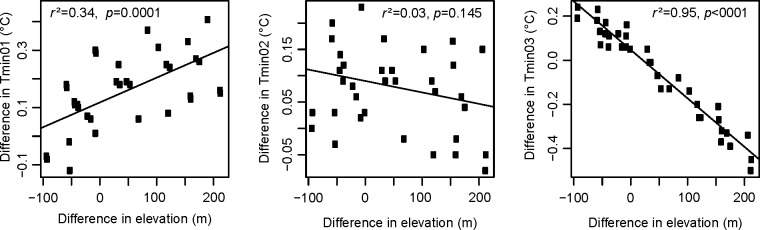
Relationships between differences in minimum temperatures in January (Tmin01), February (Tmin02) and March (Tmin03) and the change in elevation among the nine neighbor cells at a randomly picked mountain area in British Columbia (latitude = 53.88° and longitude = -125.1°).